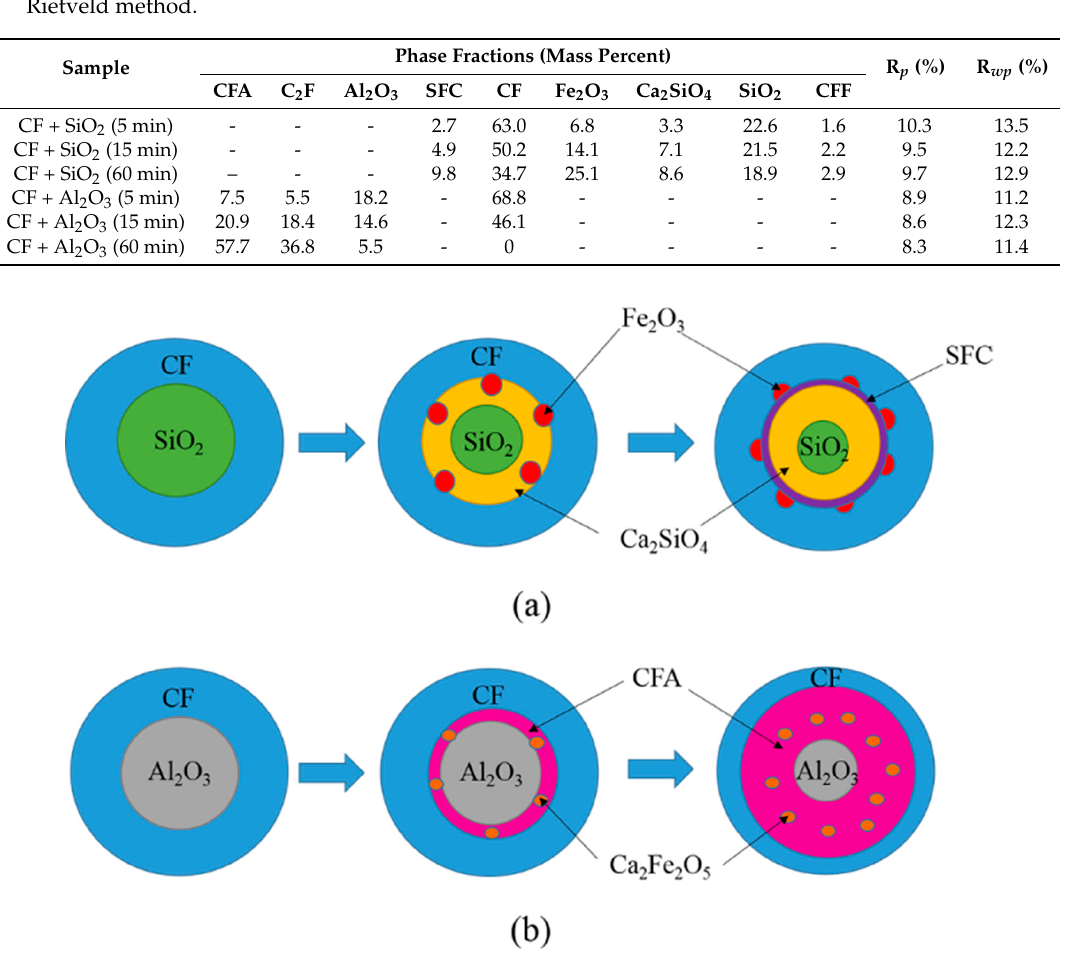
Table 2. Phase fractions of the sintering samples CF + Al 2 O 3 and CF + SiO 2 determined by the Rietveld method.